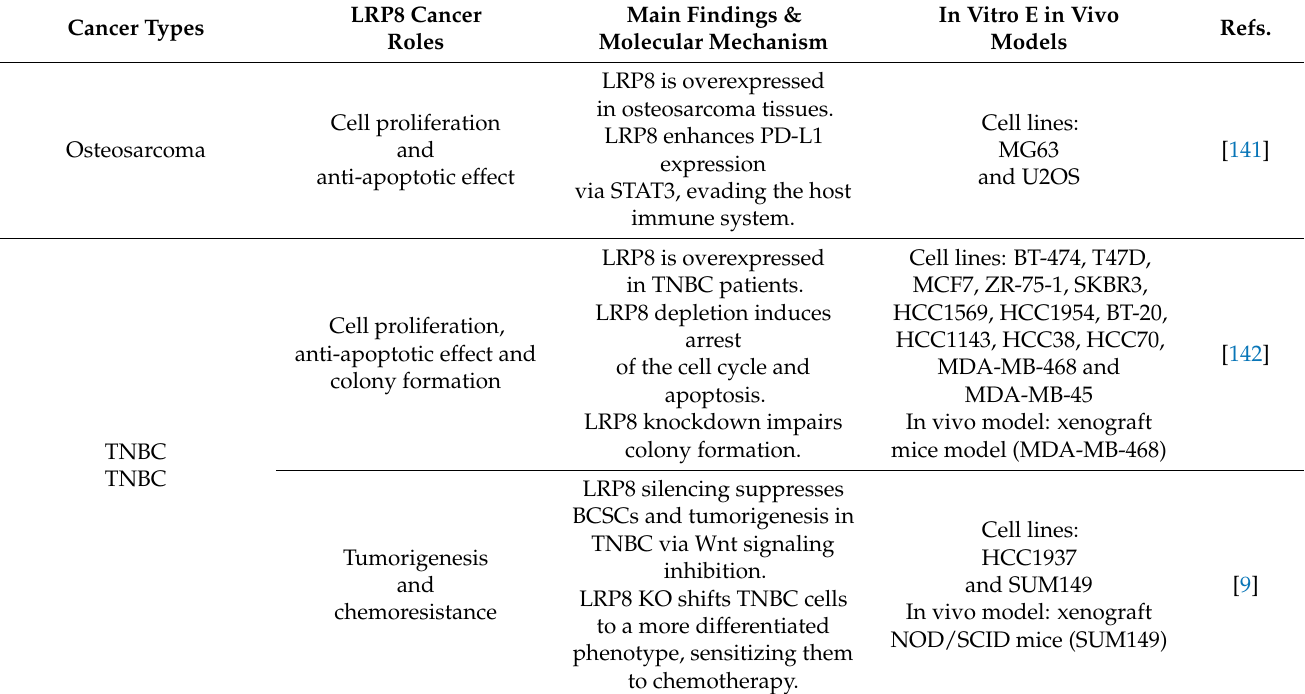
Table 2. LRP8 in cancer-related molecular pathways. The table summarizes LRP8 main findings in cancer, with the corresponding roles, molecular mechanisms and in vitro and in vivo models used (see